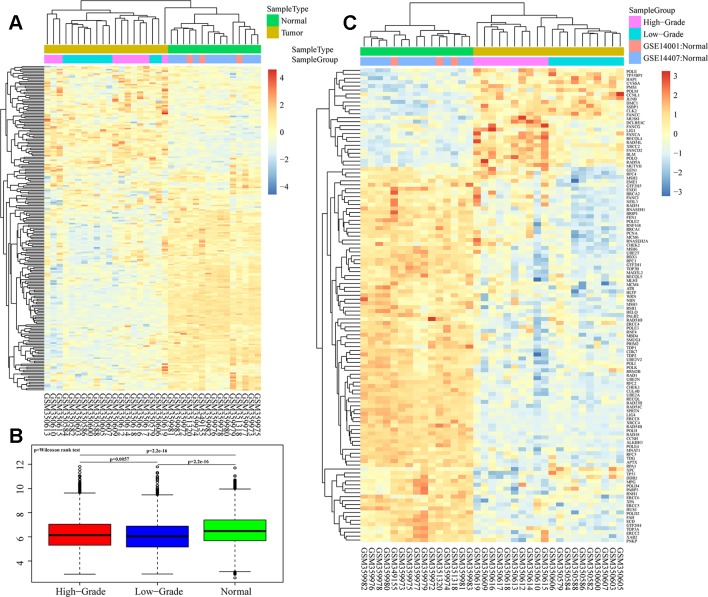
Heatmaps of DNA repair gene expression between ovarian cancer and normal samples in GSE14001 and GSE14407. (A and B) Overall expression differences of DNA repair genes in high-grade, low-grade and normal groups. (C) Cluster analysis of 120 differential gene profiles by ANOVA.